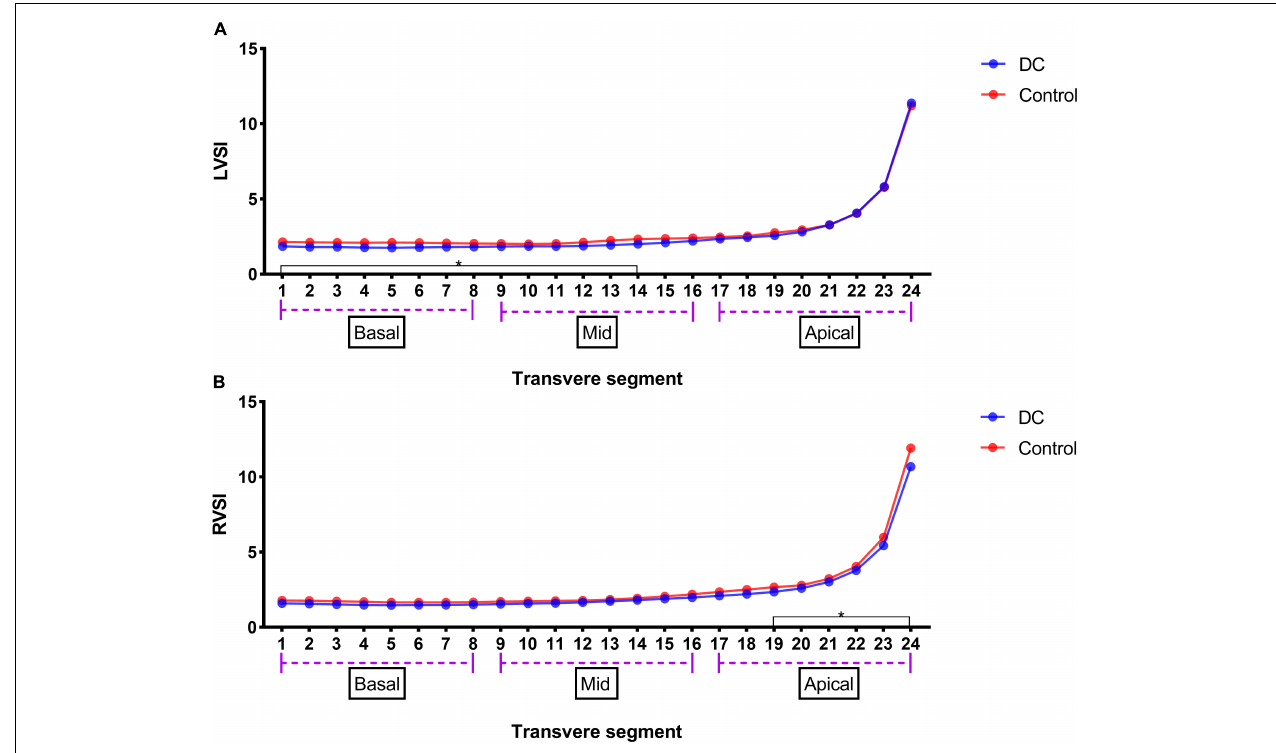
FIGURE 3 | LV 24-segments SI in the premature DA group and the control group (A) and RV 24-segments SI in the premature DA group and the control group (B) . * p < 0.05 compared in DC group and control group.